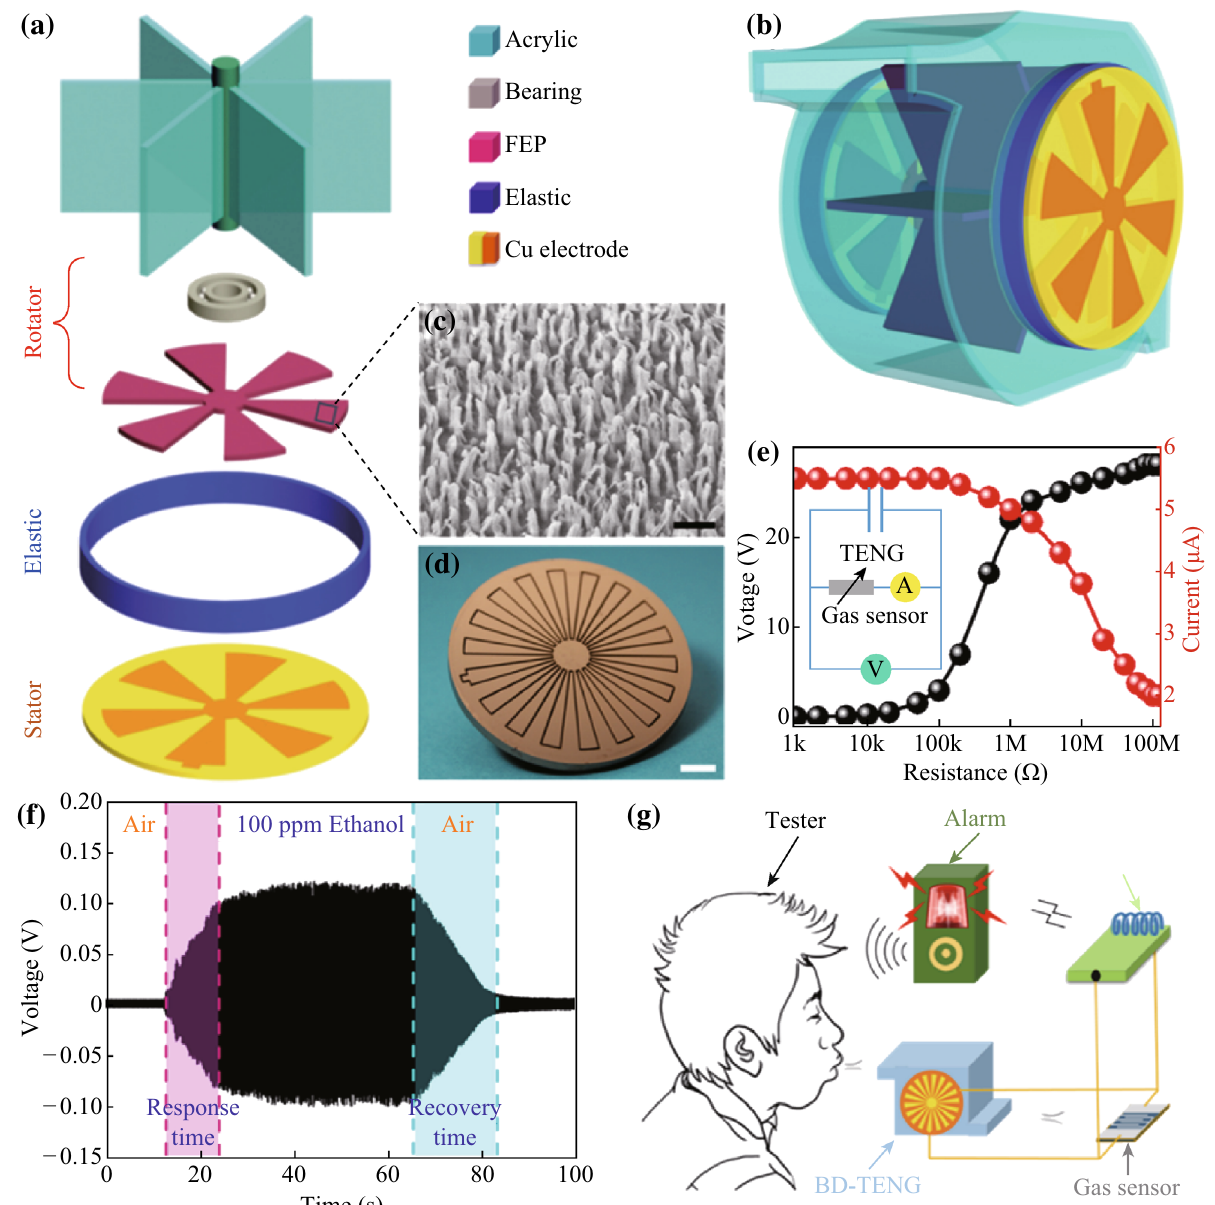
Fig. 11 Blow-driven TENG as an active alcohol breathalyzer. a Schematic illustrations of the functional components of the blow-driven triboelectric nanogenerator, which mainly consists of three parts, a rotator, a stator and a soft elastic. b A SEM image of the FEP polymer NWs ( scale bar , 500 nm). c A photograph of the as-fabricated stator ( scale bar , 1 cm). d A schematic illustration of an as-fabricated device ( scale bar , 2 cm). e The variation of the output voltage and current with external load resistances under a fixed blowing speed of 6 m/s (the inset shows the measurement circuit diagram). f A real-time continuously measured voltage profile to show the dynamic response to ambient alcohol concentrations. g A schematic illustration showing the self-power breathalyzer. Figures adapted from